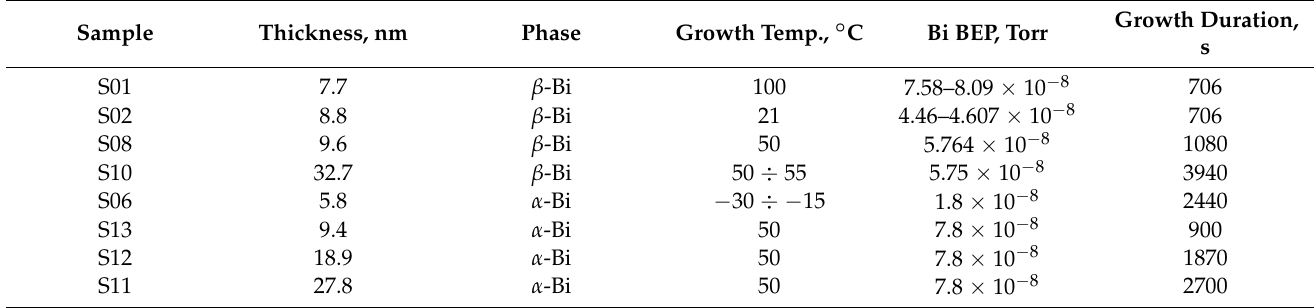
Table 1. The growth conditions and main structural parameters of the